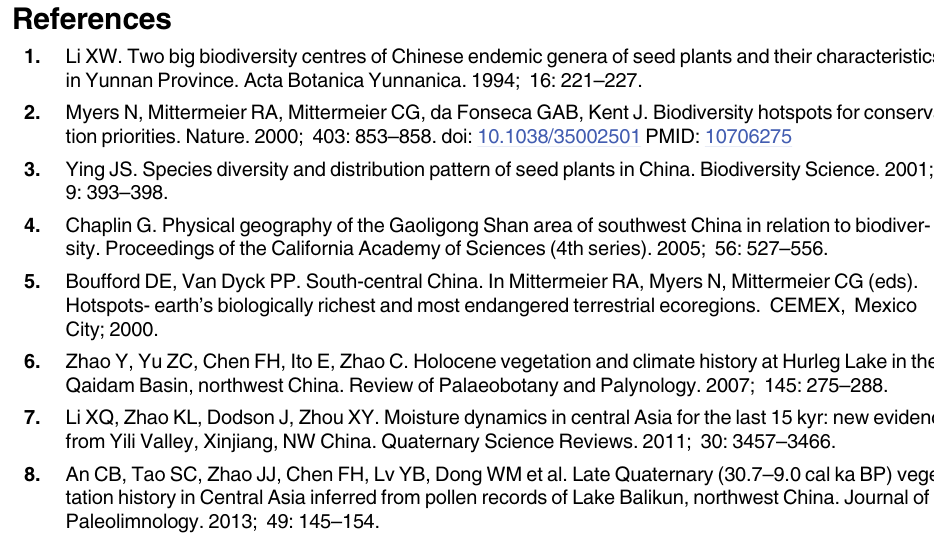
S1 Table. Inferred ages based on age-depth